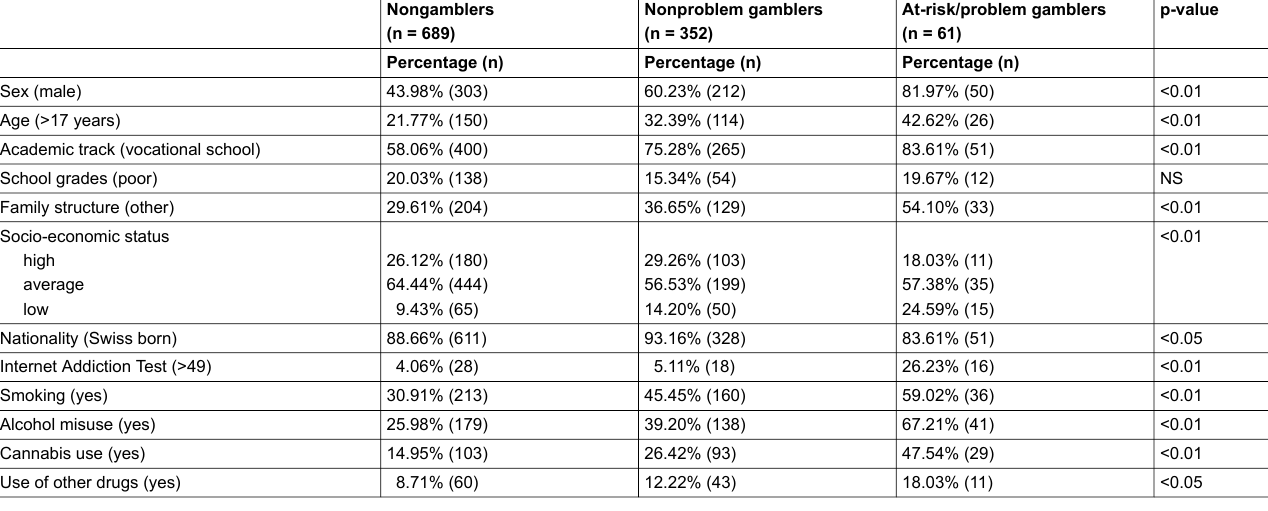
Nongamblers (n = 689)